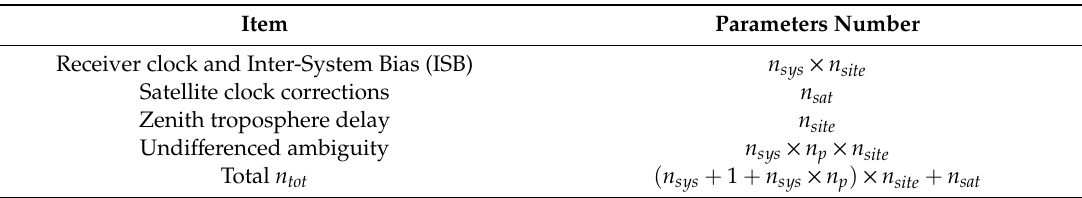
Table 1. Parameters need to be estimated at each epoch in the undi ff erenced (UD) model. Item Parameters Number Receiver clock and Inter-System Bias